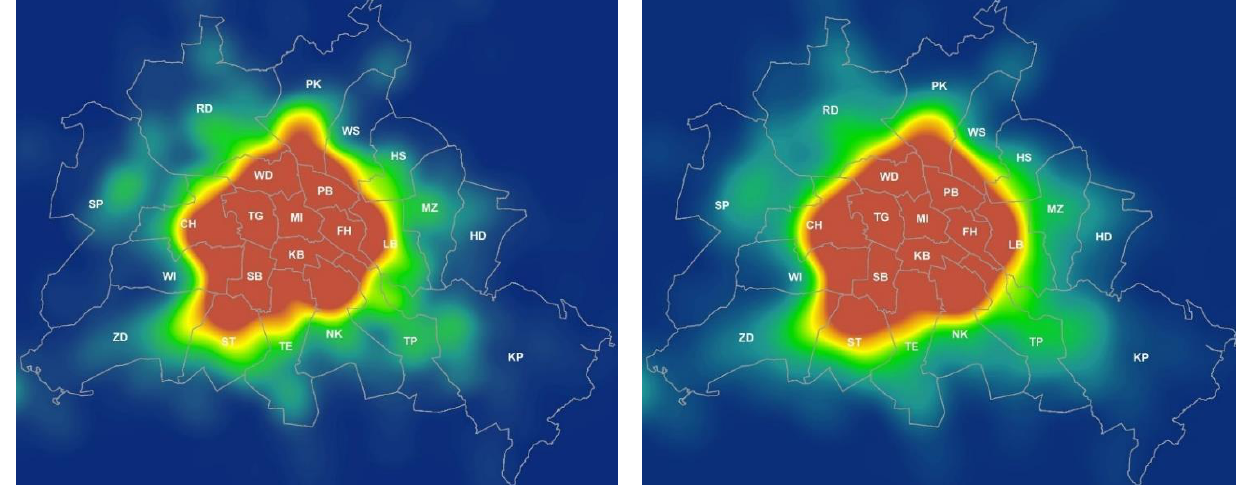
Figure 7. ( Left ): heat map illustrating origins (O) of bicycling trips in Berlin. ( Right ): Heat map illustrating destinations (D) of bicycling trips in Berlin. Red indicates higher density, moving to lower density in green. Data source: BikeCitizens. Figure source: the authors.